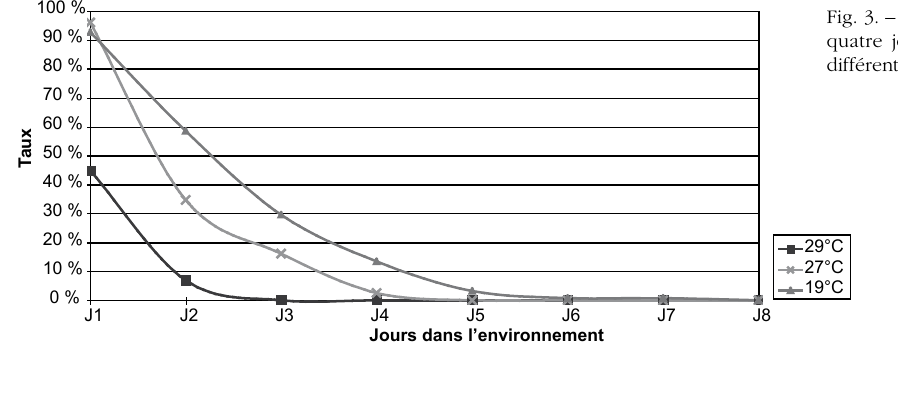
Fig. 3. – Taux de survie de C. f. strongylus de quatre jours d’âge, gorgée, en fonction de différentes